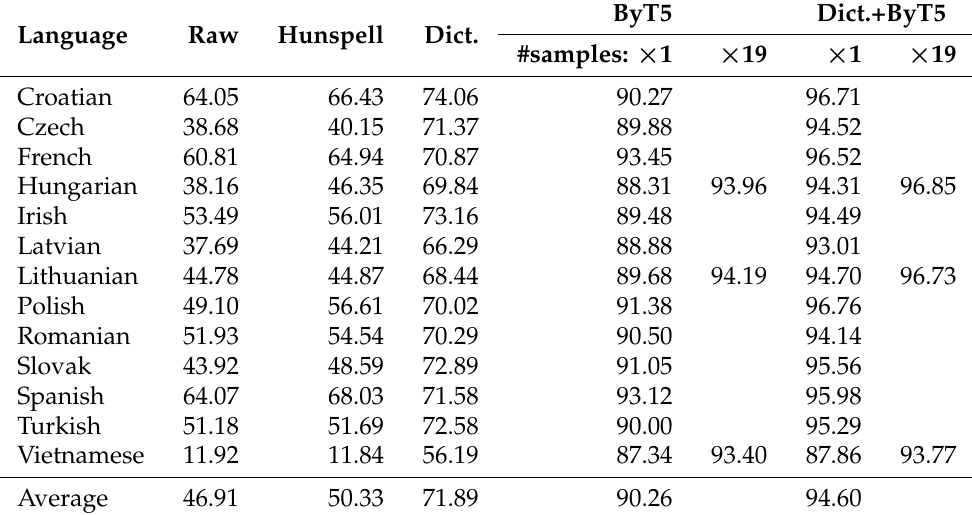
Table 5. Alpha-word accuracies for the simultaneous diacritics and typographic error corrections. Language